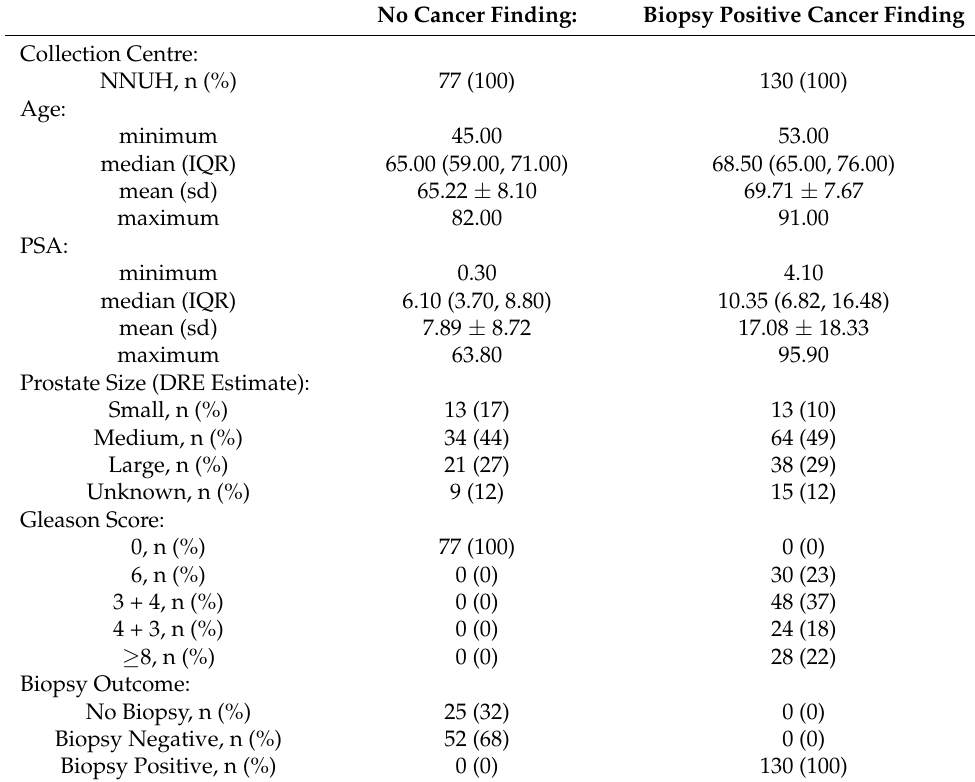
Table 1. Characteristics of the ExoGrail development cohort, stratified according to a record of cancer or not, either on an initial biopsy or for a no cancer finding if a biopsy was not performed. No Cancer Finding: Biopsy Positive Cancer